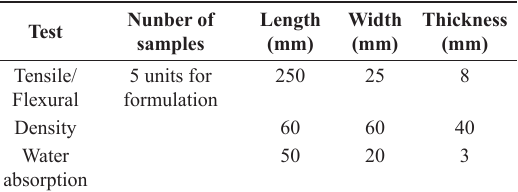
Table 1. Dimensions of the specimens for characterization